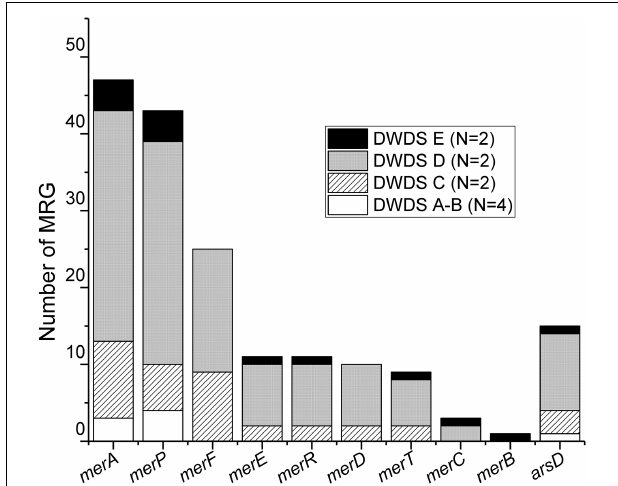
FIGURE 4 | Distribution of MRGs in various DWDSs (A–E). DWDS A and B are pooled together due to the presence of a low number of MRGs in these samples. N, number of